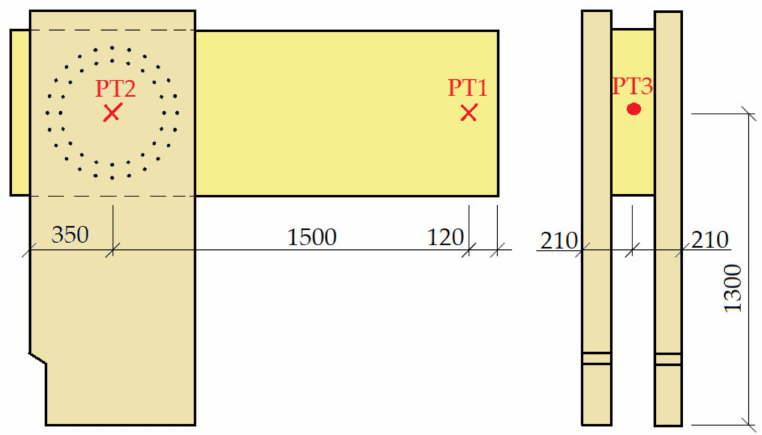
Figure 5. Deformation sensor location display, front view on the left, side view on the